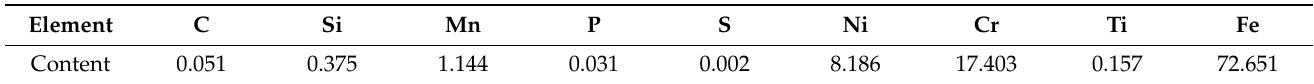
Table 2. Material